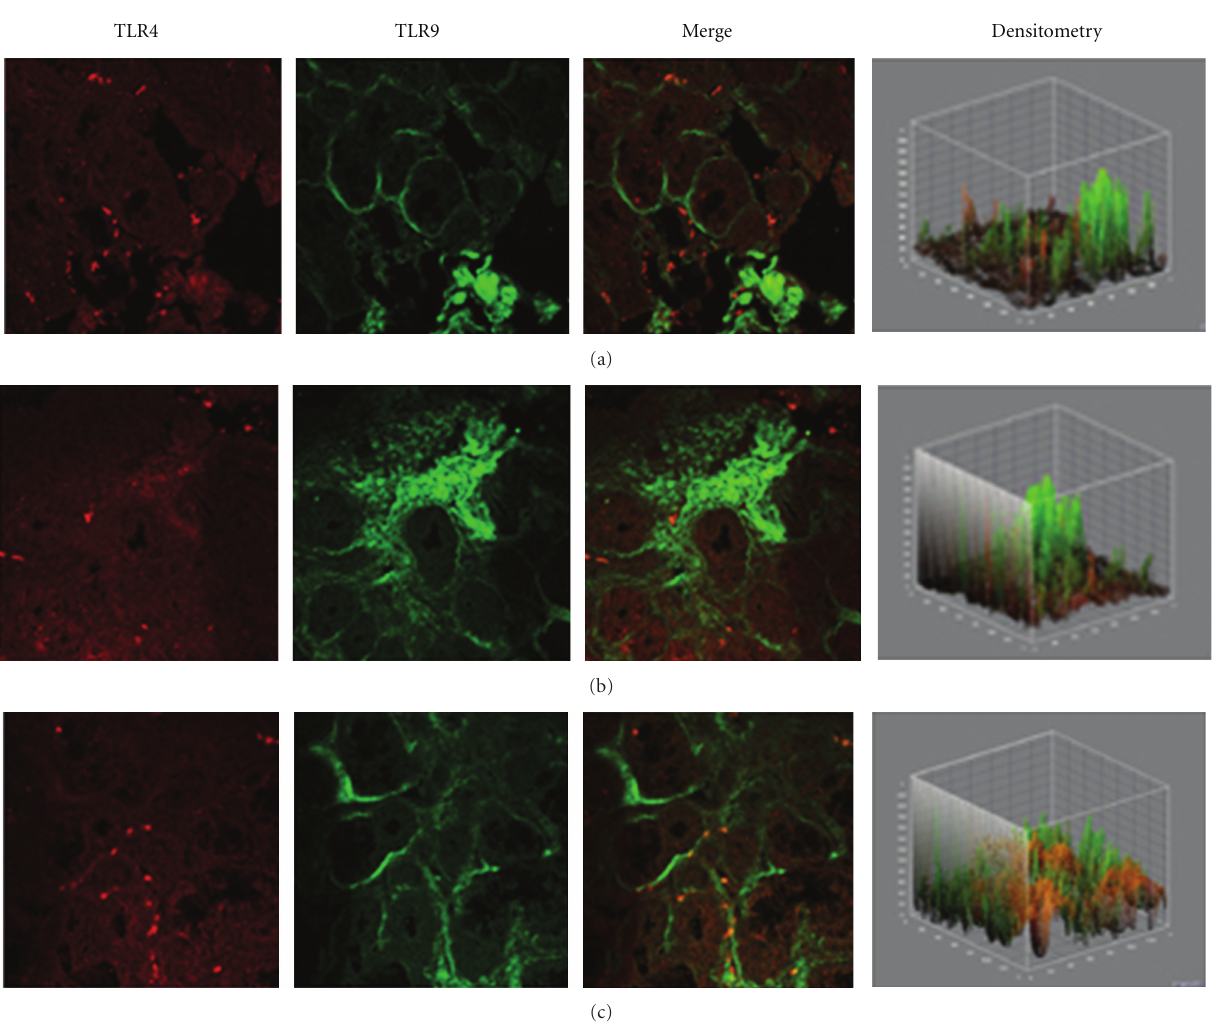
Figure 2: TLR4 and TLR9 expression in allergic rhinitis. Confocal analysis showing a consistent low expression of TLR4 (a, c) and a reduced expression of TLR9 at the stromal level (a) and (b), as indicated by a white arrow in (b) ×